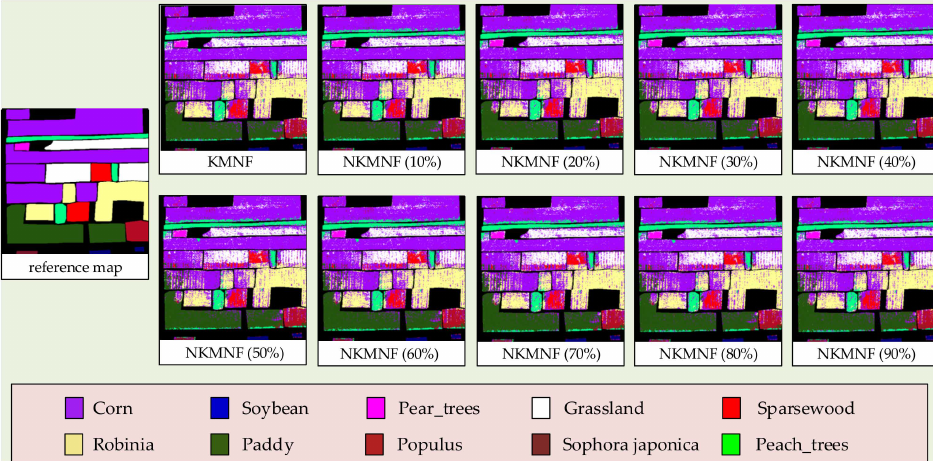
Figure 13. The results of SVM classifier for Indian Pines after NKMNF with different proportion sample sizes (number of features = 45).